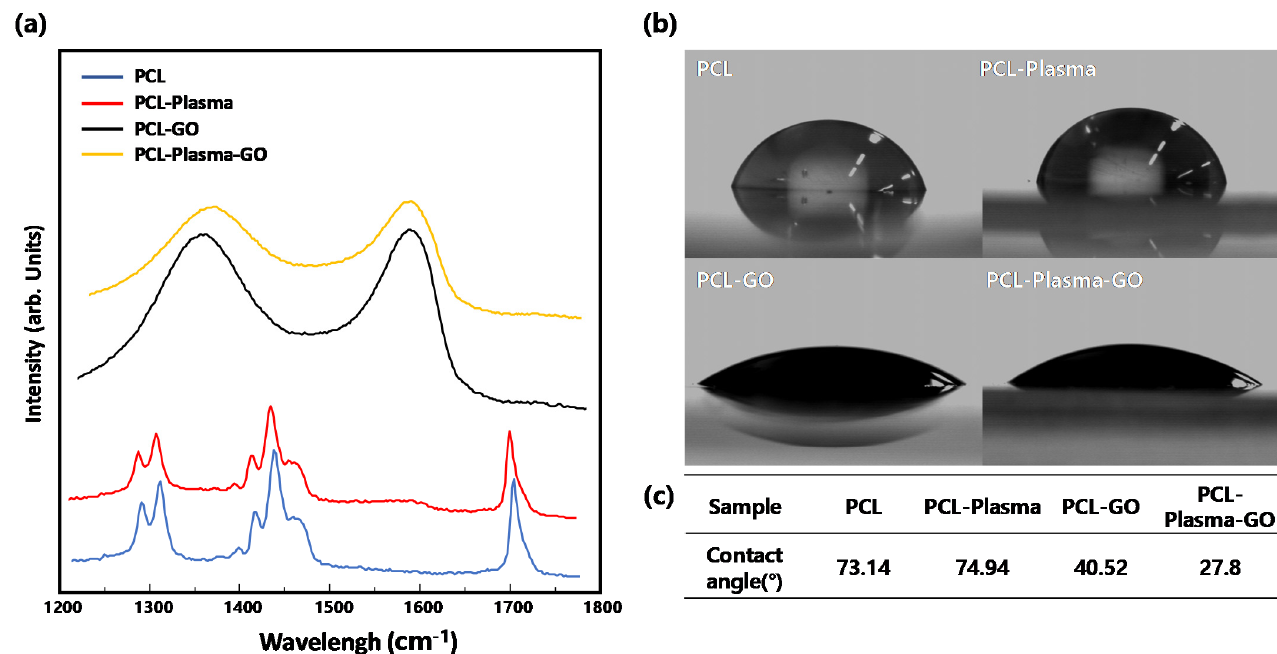
Figure 2. Physical properties of the scaffolds. ( a ) Raman spectra of poly( ε -caprolactone) (PCL), PCL-plasma, PCL-graphene oxide (GO), and PCL-plasma-GO; ( b ) Contact angle and images of PCL, PCL-plasma, PCL-GO, and PCL-plasma-GO; ( c ) Table summarizing the contact angle of PCL, PCL-plasma, PCL-GO, and PCL-plasma-GO.